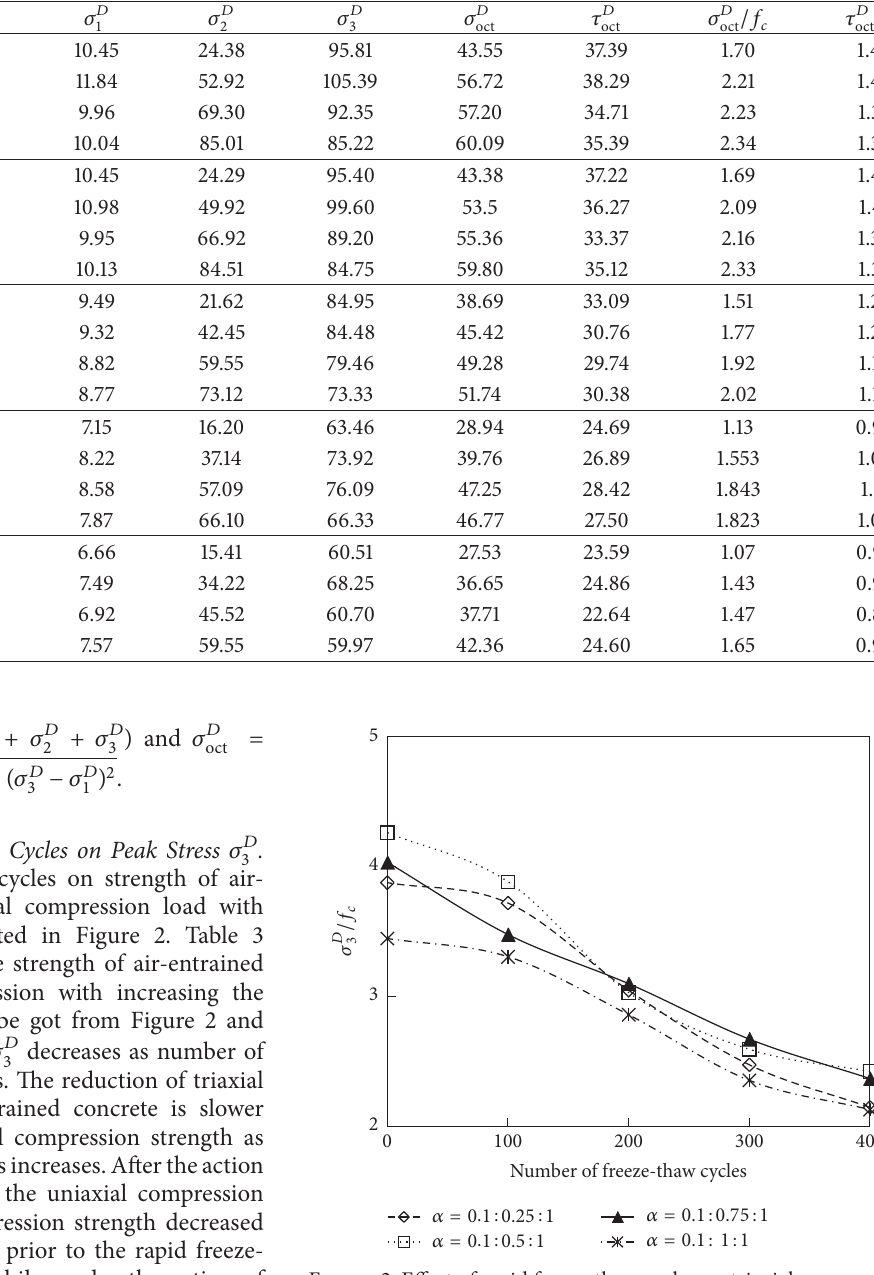
Figure 2: Effect of rapid freeze-thaw cycles on triaxial compressive strength under different intermediate stress